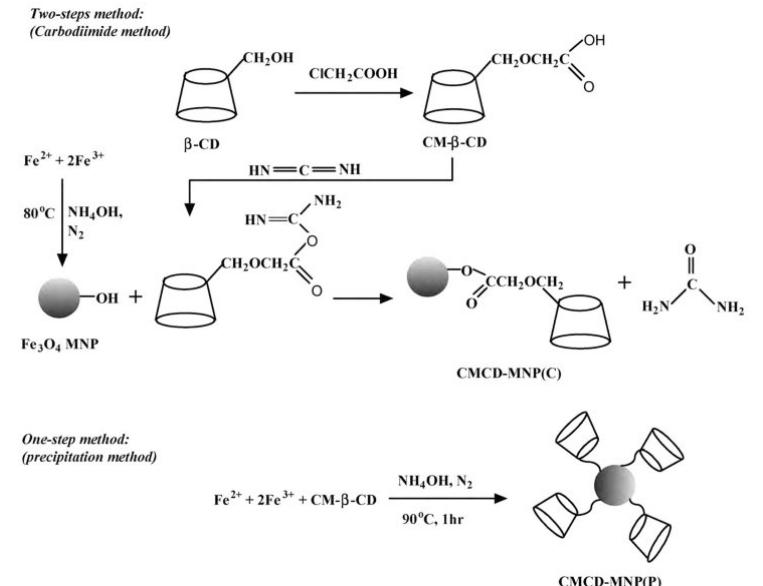
Fig. 3. An illustration for the carboxymethylation and binding of CD onto the Fe Fig. 3 An illustration for the carboxymethylation and binding of CD onto the Fe 3 O 4 nanoparticles [11]